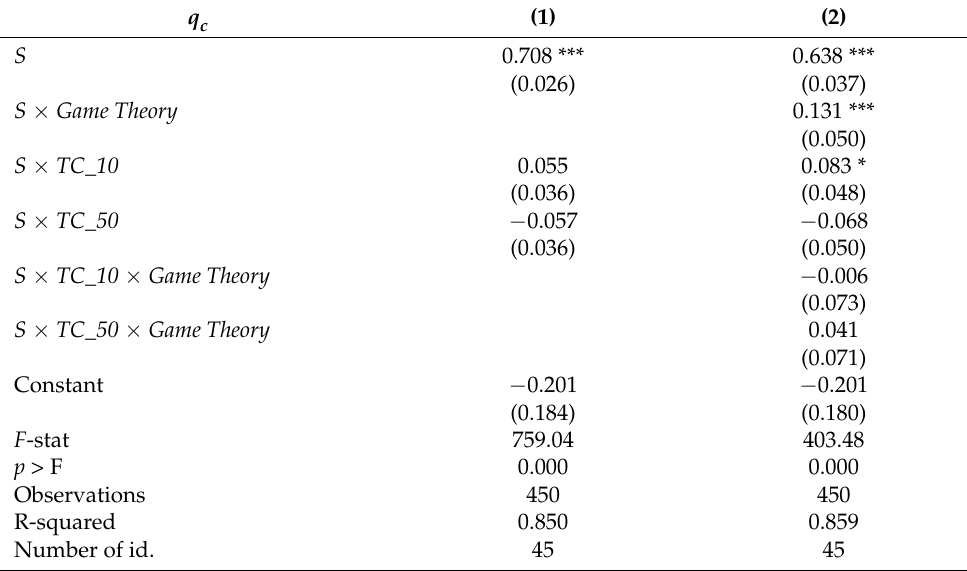
Table 8. The behavior of the third agent (corruption